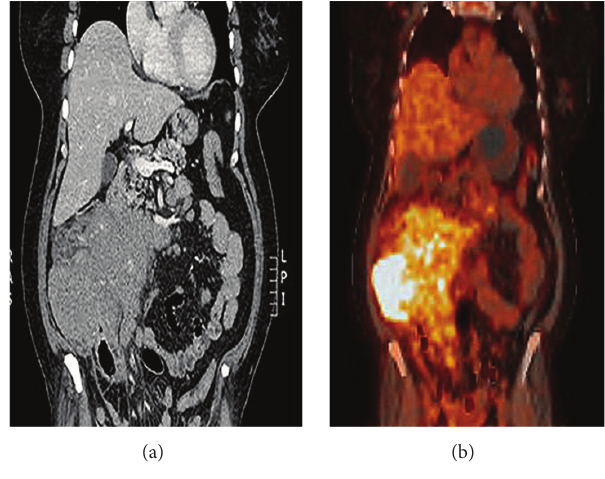
Figure 1: PET-CT scan image.